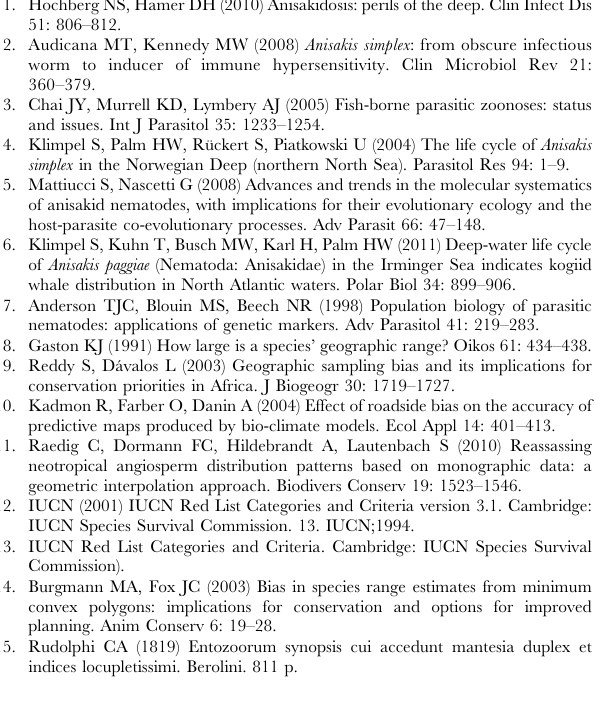
Figure S2 Zoogeographical interpolation approach in four steps. (A) geographical information where transferred onto a grid of 1 u 6 1 u covering the globe. Corresponding quadrats marked as occurrence for each species. (B) The final hull resulting from those centroids, which are connected by a line smaller than a multiple of the average line length ( a -Parameter). (C) Distribution ranges were defined as the corresponding quadrats intersecting the created polygons. (D) Range was calculated for 25 different a - values ranging from 2 to 50 in a two-step interval. Results were visualized by a continuous colour gradient (Figure 1). Table S1 Information on parasites sampling locations and hosts. Sampling locations of the 373 anisakid nematodes used for molecular analyses including abbreviation (Abb.), host and sample size (n). Asterisks mark multiple sampling sites with the same abbreviation (see Figure S1). Table S2 Total numbers of identified anisakid nema- todes including hosts and sampling location. For